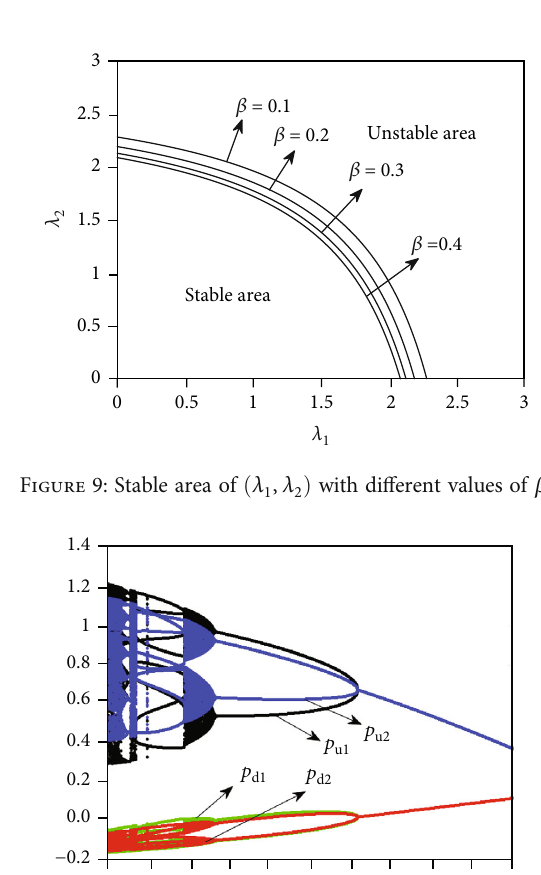
Figure 10: Bifurcation diagram with respect to β changes when α = 2 : 1, λ = 1 : 5 , p ð 1 Þ = 0 : 1, p ð 1 Þ = 0 : 3 , and = 0 : 5, d = 1, λ 1 2 u 1 u 2 1 iteration = 700 .